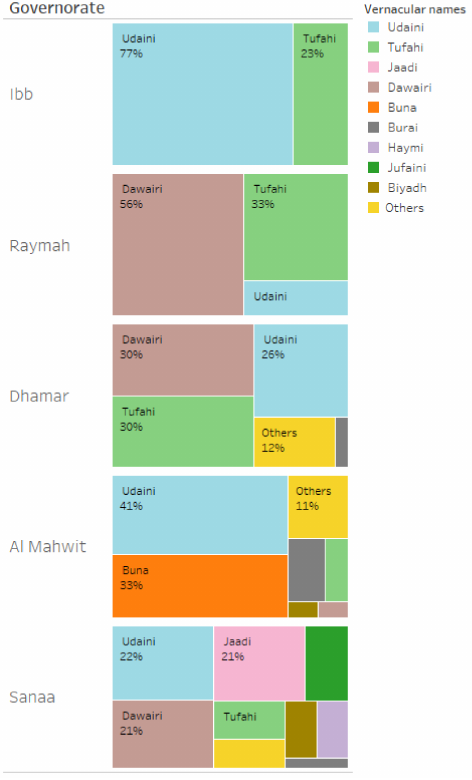
Figure 3. Share of vernacular coffee names mentioned on 148 farms from different governates in Yemen. In each cell (=governorate), the area for each name is proportional to its frequency. The sum of frequencies in each governorate is equal to